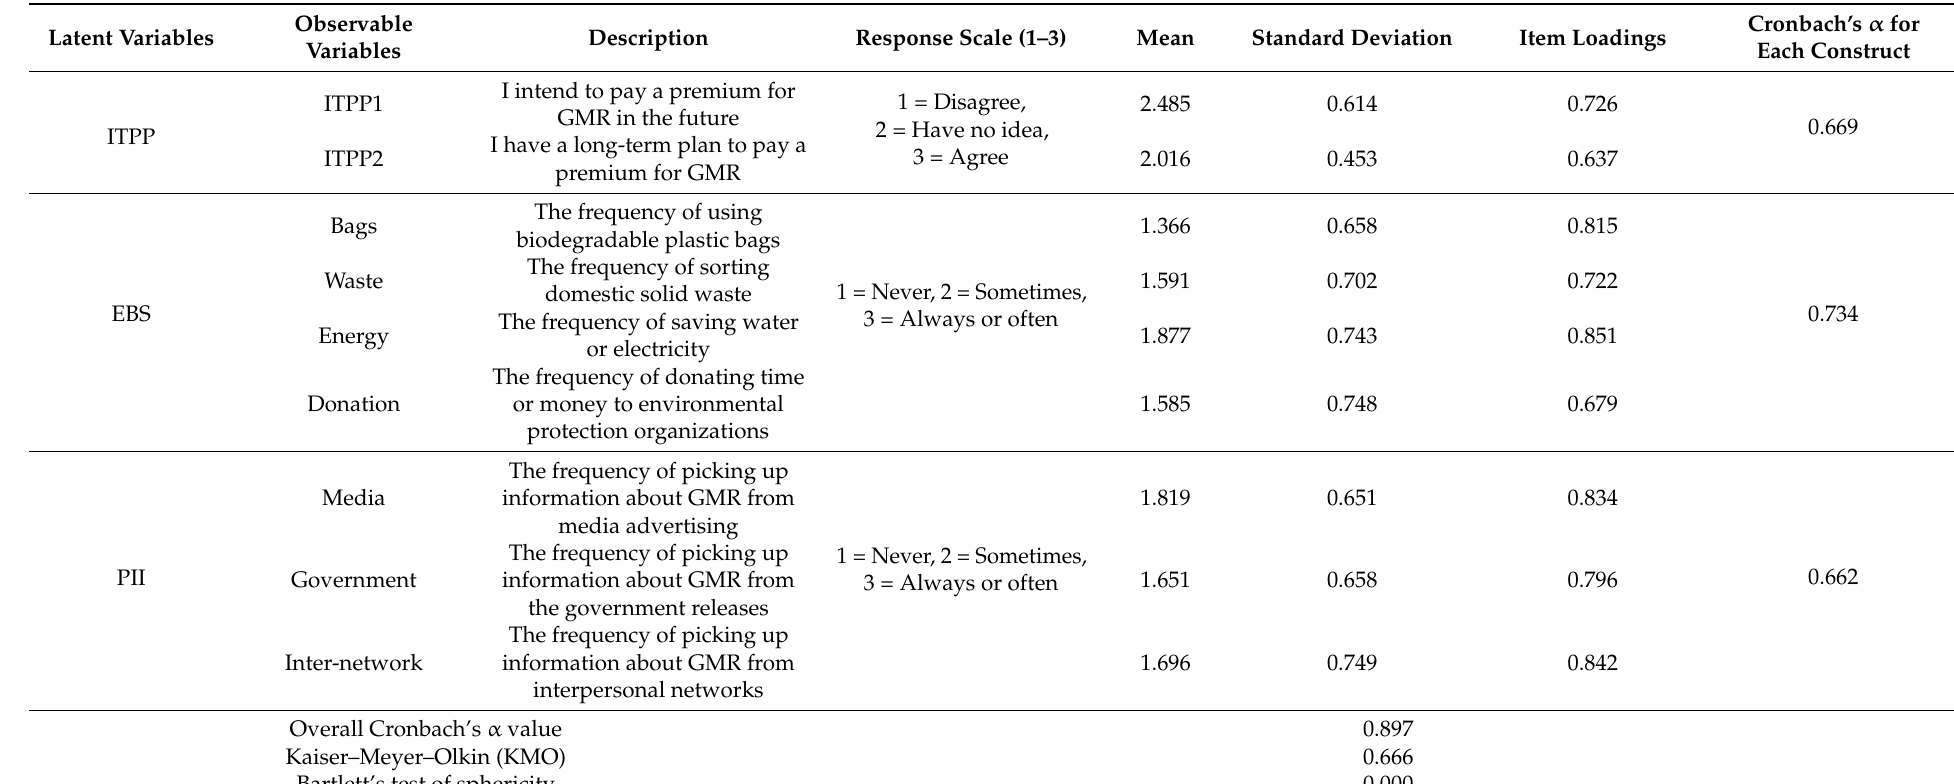
Table 4. Descriptive statistics of the